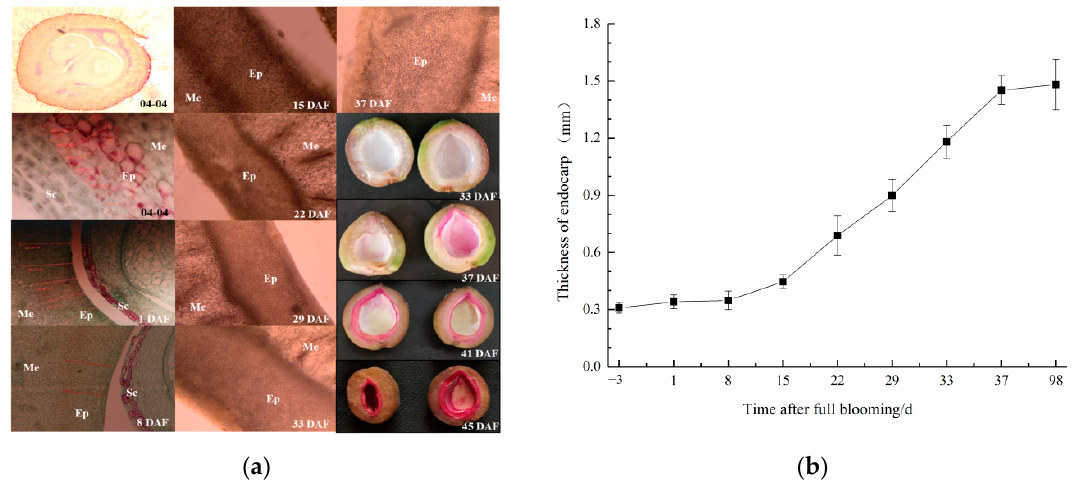
Figure 1. ( a ) Changes of tissue and lignin deposition during endocarp developing. Me, Mesocarp; Ep, Endocarp; Sc, Seed coat. 04-04, Ovaries and endocarp stain with saffron; 1 and 8 DAF, seed coat separate from endocarp; plates from 15 to 37 DAF show thickening of the endocarp; the right row of plates show endocarp lignin deposition stained with phloroglucinol. ( b ) Changes of tissue thickness during endocarp developing. Each period is repeated 5 times sampling, and the endocarp thickness is measured in n = 25.